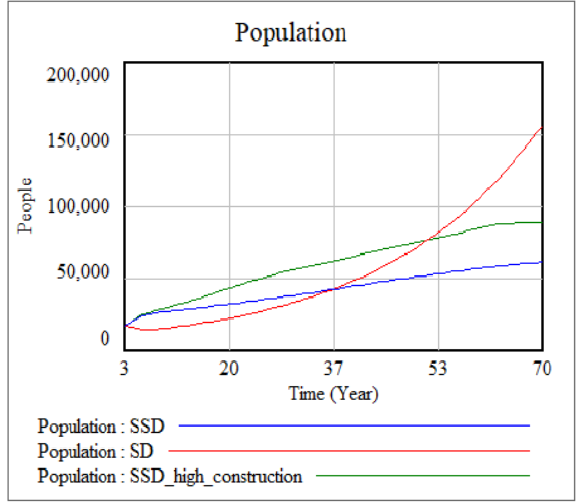
Figure 5: Simulation for two scenarios with respect to the population